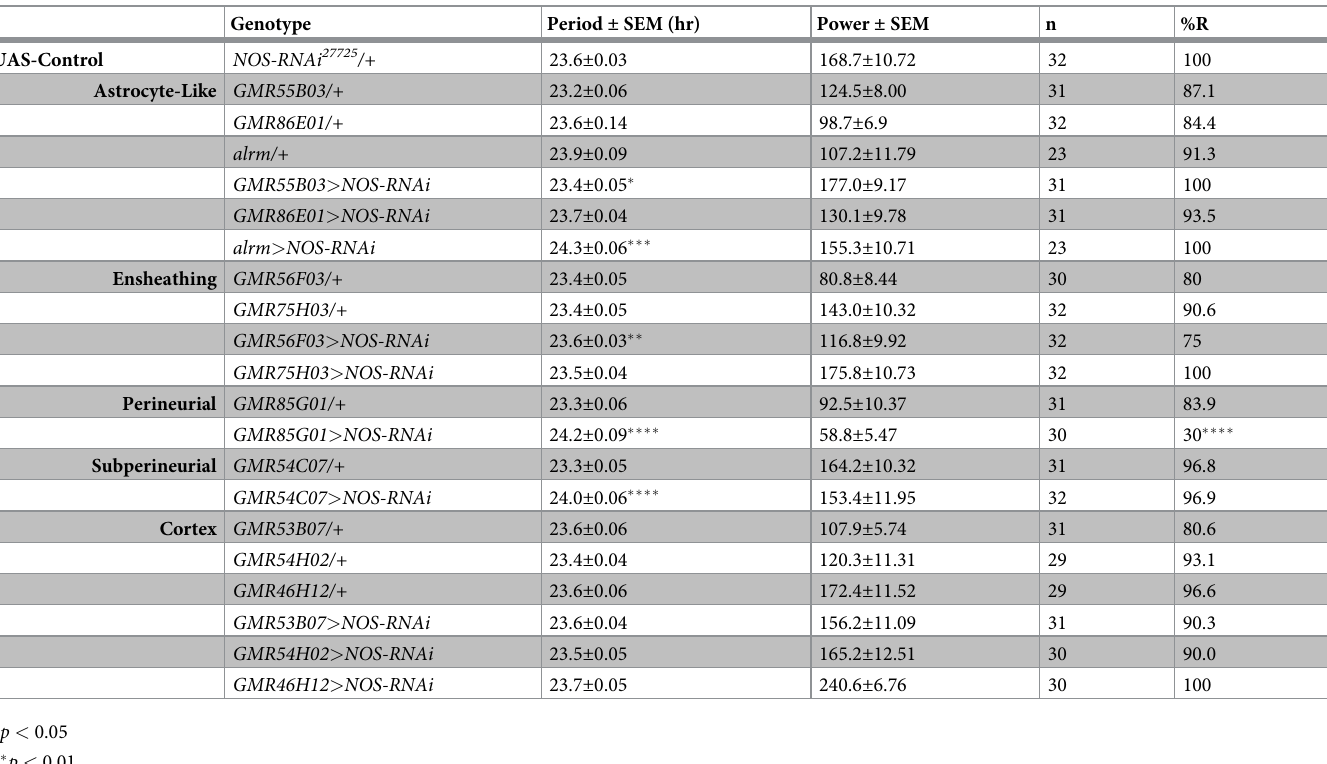
Table 2. Effect of NOS knockdown in glial subpopulations on free-running locomotor rhythms. The left-most column indicates the expression of drivers are expressed. n , number of flies. %R, % of rhythmic flies. Mean periods and rhythmicity of the test groups were compared with those of GAL4-only controls using Student’s t- test and chi-square test,